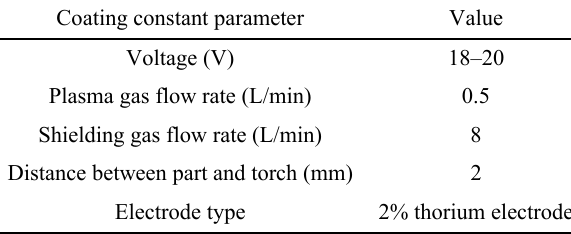
Table 3 Coating constant